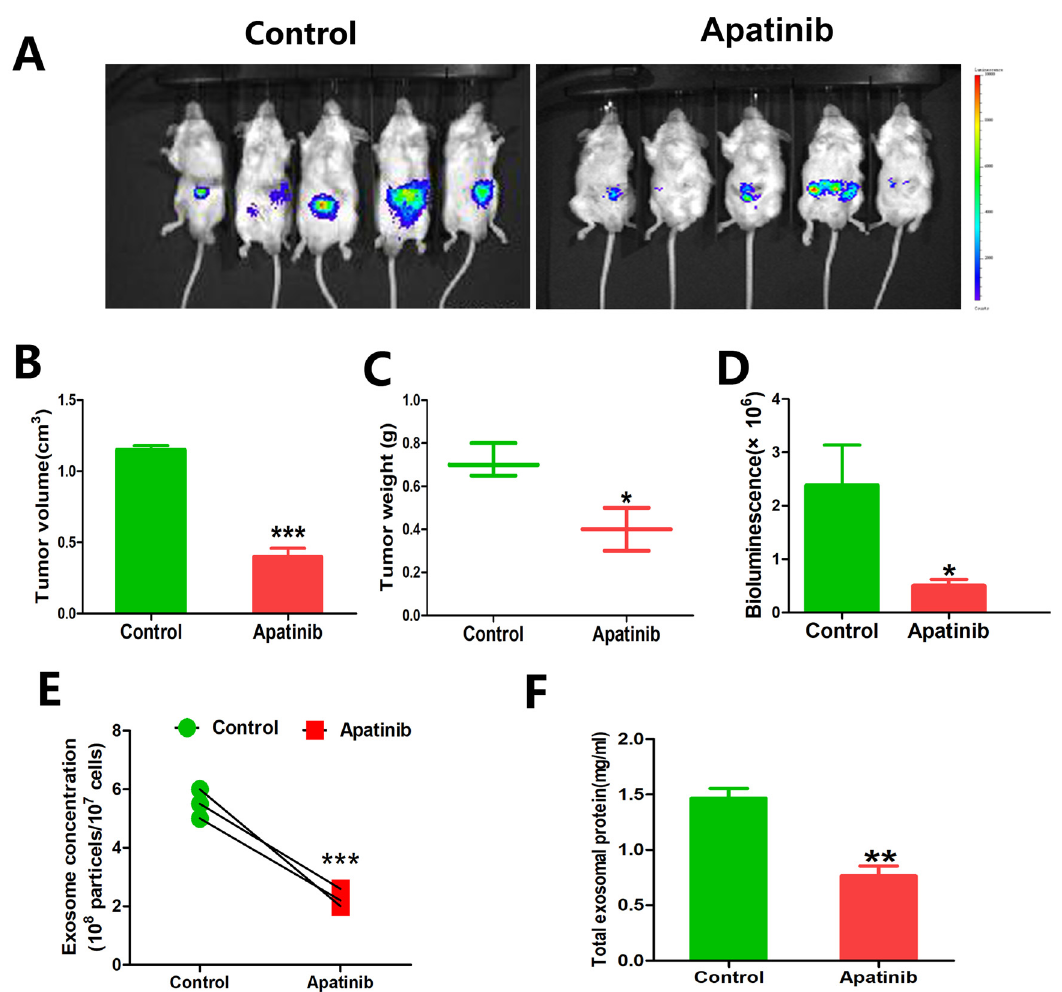
Figure 8. The antitumor efficacy of apatinib and exerted exosome inhibition in vivo. ( A ) Biolumines- cent imaging for RKO-luc orthotopic xenograft colon tumors in the control vs. apatinib group ( n = 5 per group). ( B – D ) Comparison of the tumor volume, tumor weight, and bioluminescence between the control and apatinib group. ( E ) NTA showed the concentrations of serum exosomes isolated from the control and apatinib group. ( F ) Quantification of the serum exosomal protein levels obtained from the control and apatinib treatment mice. * p < 0.05, ** p < 0.01, and *** p <